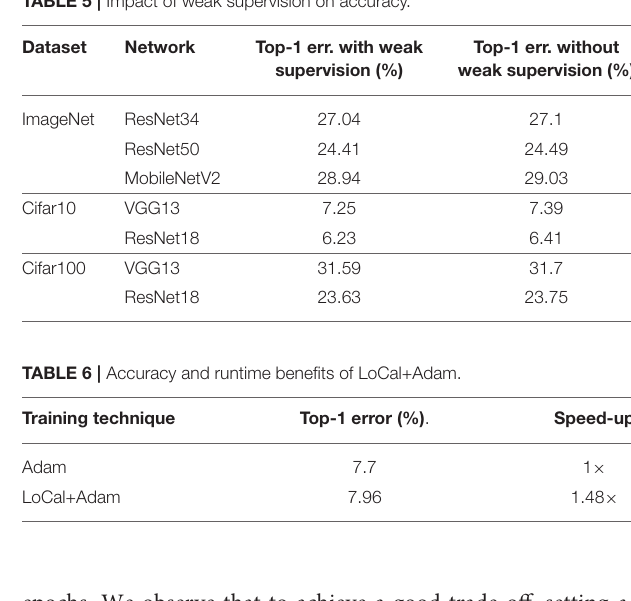
TABLE 5 | Impact of weak supervision on accuracy.